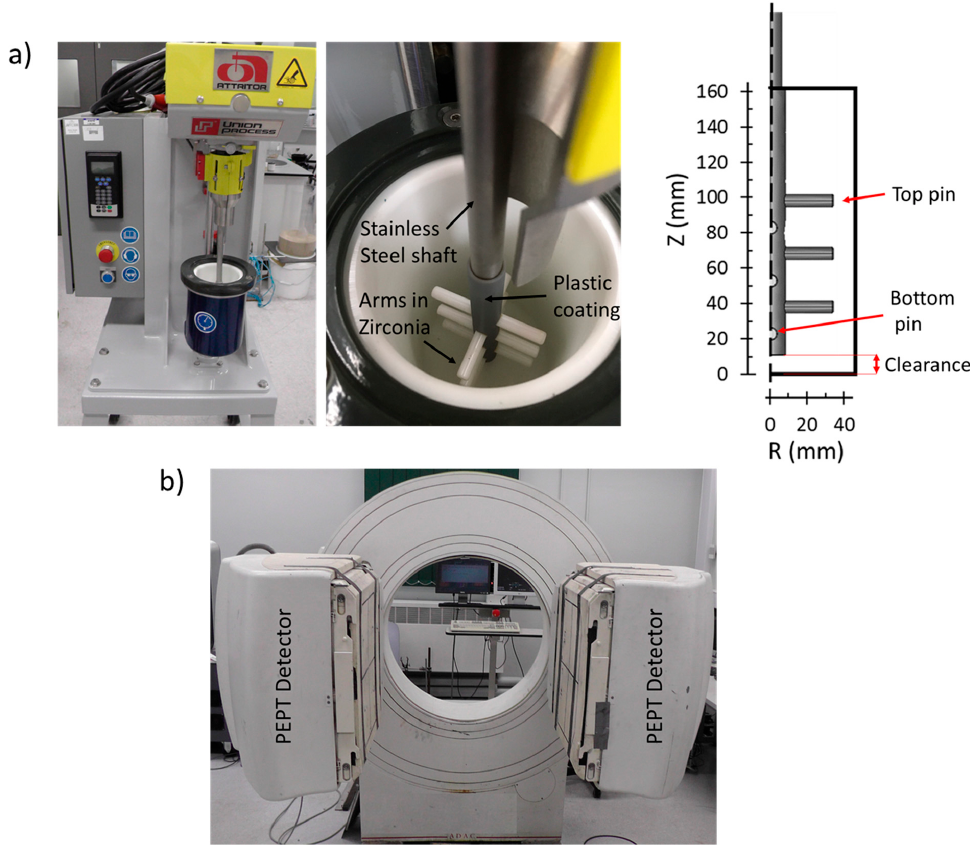
Figure 1. Experimental rig: ( a ) attritor mill HD1 (Union Process, Akron, OH, USA) with a schematic of the vessel showing the pin positions for the clearance of 12.7 mm (1/2 inch) and ( b ) PEPT scanner (University of Birmingham, Birmingham, UK). Table 1. Detail of the mill dimensions.